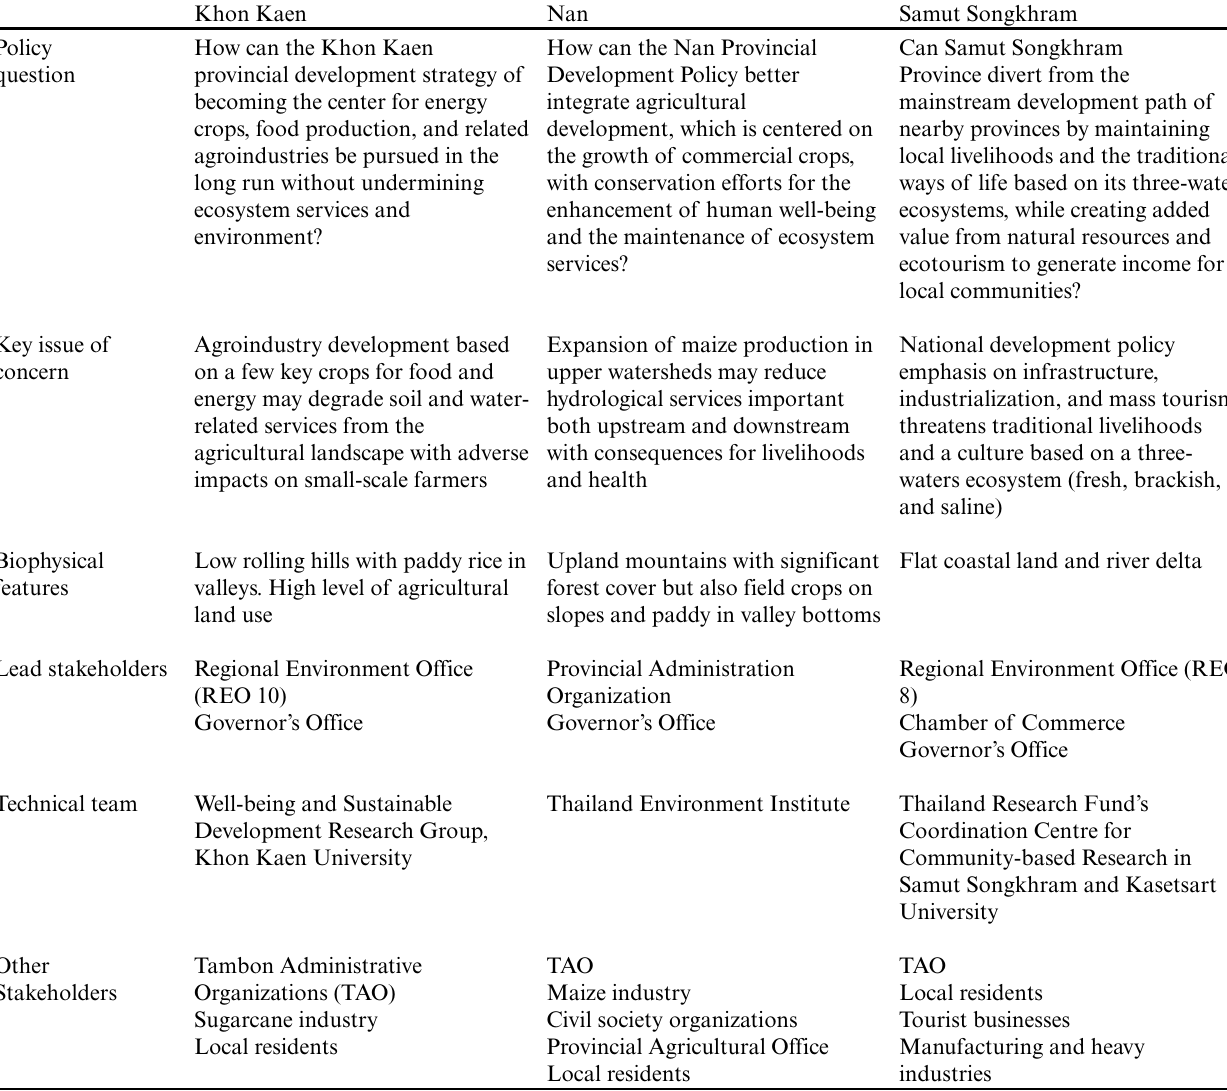
Table 1 . Policy question, key issues, biophysical features, and stakeholders for the assessments in three